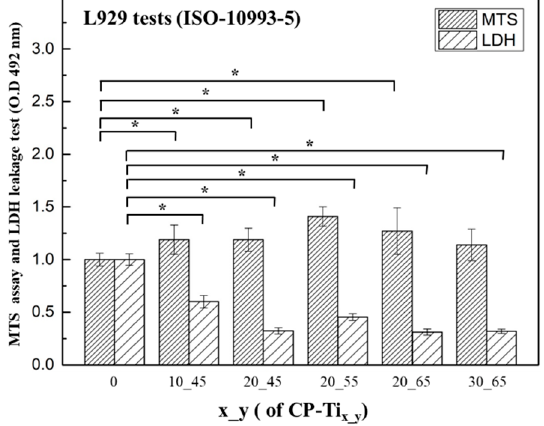
Figure 6. L929 Cell affinity was examined by MTS assay and lactate dehydrogenase (LDH) leakage test upon the surfaces of CP-Ti x_y : CP-Ti 10_45 , CP-Ti 20_45 , CP-Ti 20_55 , and CP-Ti 20_65 . For MTS assays, significant increases on cell viability were found on all the surfaces. For LDH leakage tests, significant reduction on cell death was found, except for the surface of CP-Ti 10_45 . *: p < 0.05 had statistical differences.